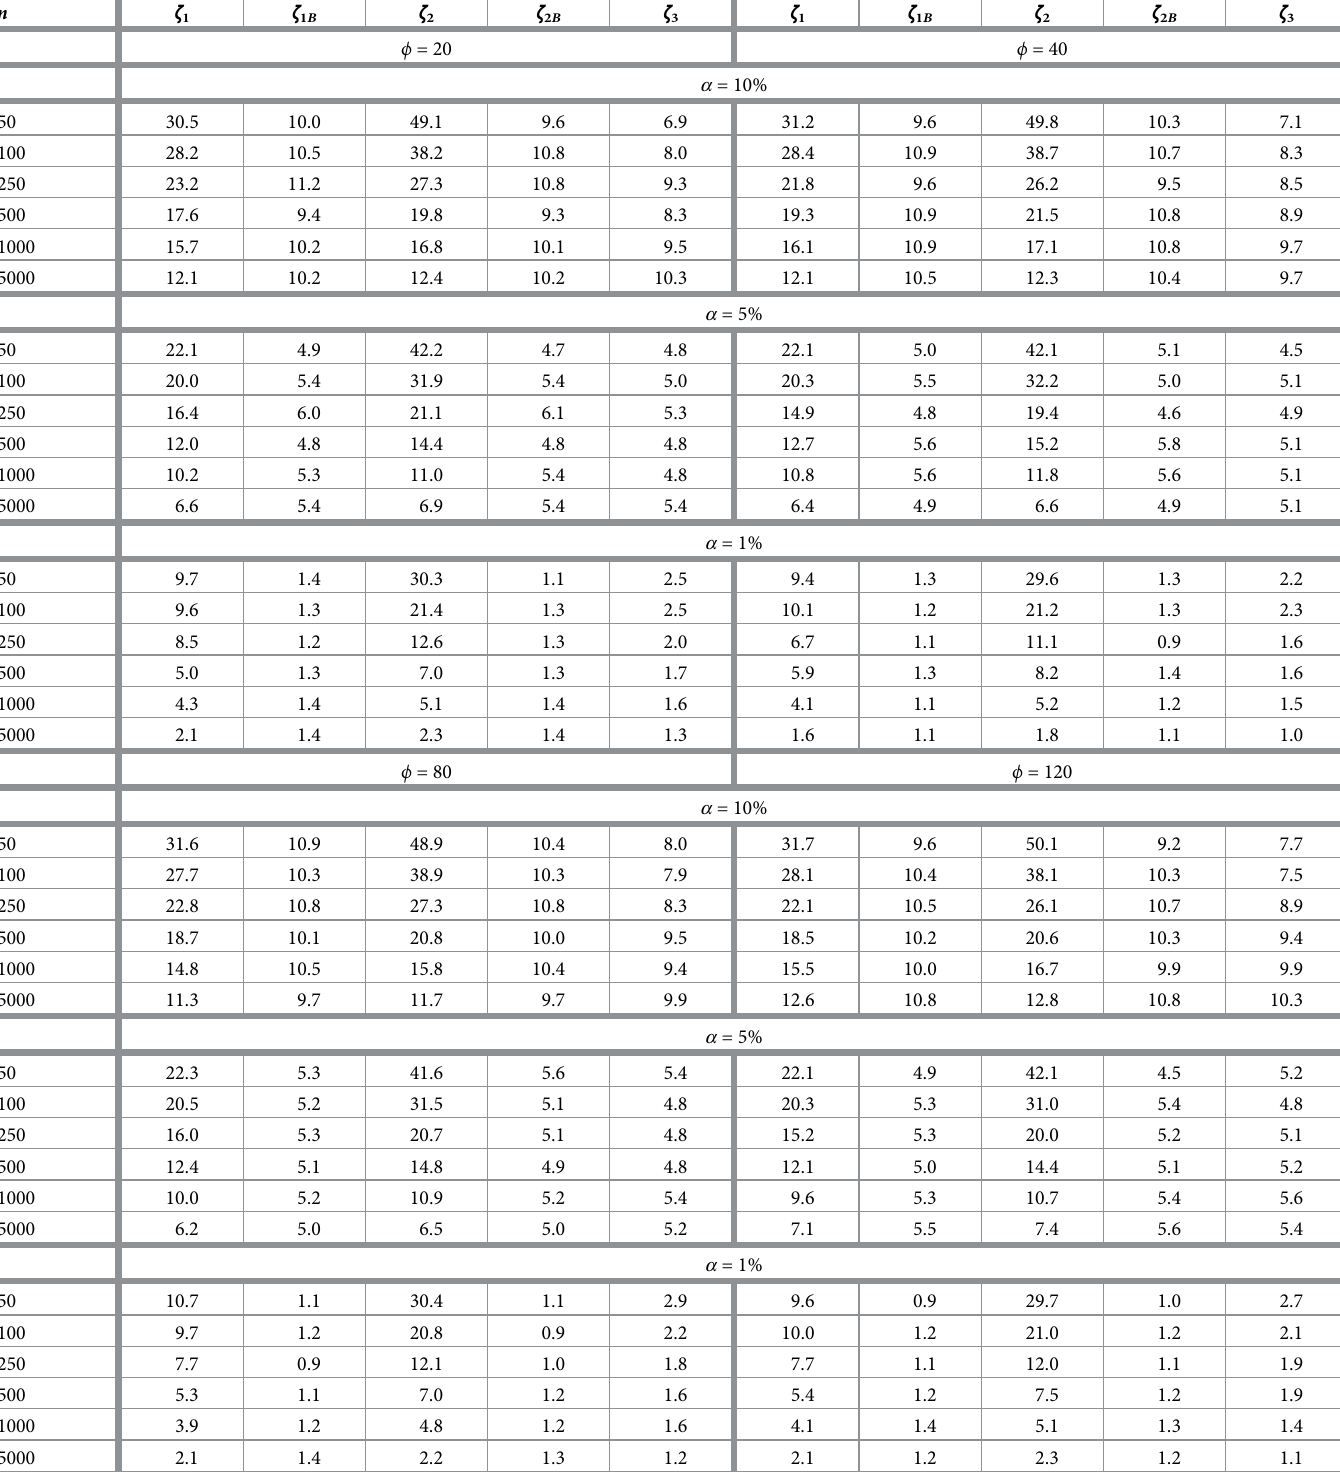
Table 2. Null rejection rates (%), μ =